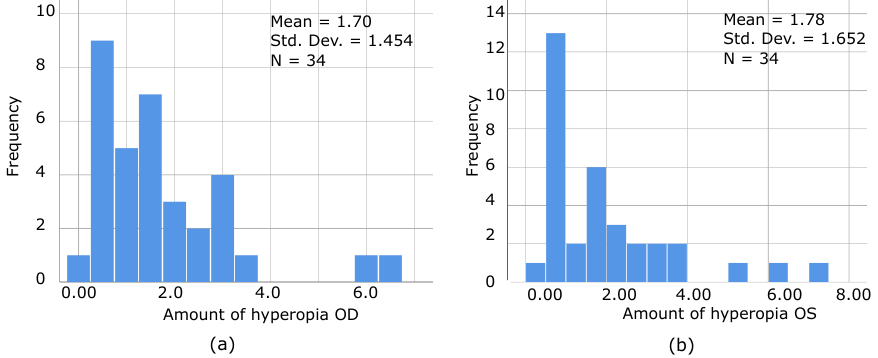
Figure 9. ( a , b ) Shows the distribution of frequencies of the amount of hyperopia of the right and left eye in stereoblind PS, where even patients with low degrees of hyperopia can be stereoblind. This reaffirms what statistics have already proven, that the amount of hyperopia does not predict the presence or absence of